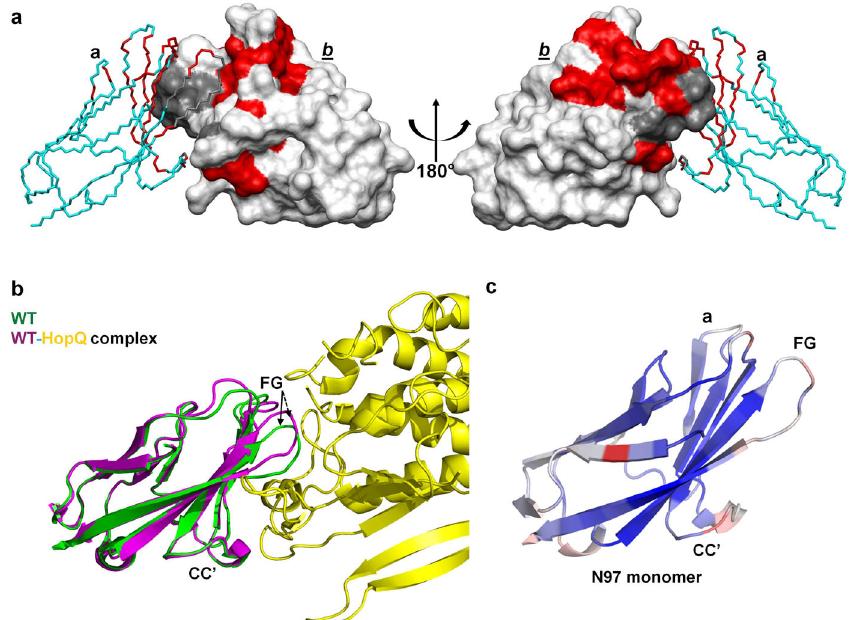
Fig. 8 Mapping of NMR chemical shift changes of N97A mutant rendered on WT structure and conformational fl exibility of the GFCC ′ face. a Front (left) and back (right) views of the crystal structure of the hCEACAM1 WT IgV dimer (PDB code 4QXW) with one unit shown in molecular surface representation (white) and another in alpha carbon traces (cyan). The residues in N97A mutant hCEACAM1 IgV with combined 1 HN and 15 N NMR chemical shift changes larger than 0.2 ppm are colored in red, while residues with missing assignments presumably due to dynamic conformation exchanges are colored in gray. b Structural alignment of a hCEACAM1 molecule of WT homodimer in green (PDB code 4QXW) with a hCEACAM1 molecule of WT-HopQ complex crystal structure in magenta (PDB code 6AW2). For clarity, only half of the HopQ molecule (yellow) is shown. CC ′ and FG loops are labeled, and the conformational differences of the FG loop are depicted by an arrow. c The ribbon diagram of the molecule (a) of N97A crystal structure with B-factor assignment. The loops, α helices, and β strands are colored based on B-factor range (blue-white-red, where blue minimum = 10, red maximum = Methods Protein expression and puri fi cation . The hCEACAM1 WT IgV and mutant (V39A, I91A, N97A, E99A) proteins were expressed and puri fi ed using our pub- lished protocols 13 .